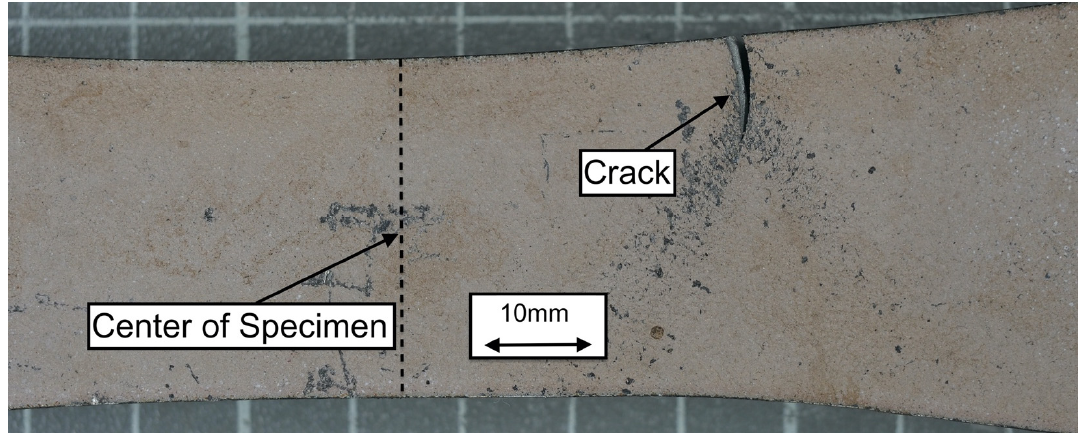
Figure 8. Specimen where the crack position is not at the smallest cross section.